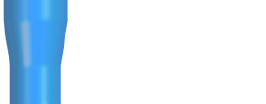
Figure 1. Two-dimensional diagram of the axial-flow pump. 1. Pipe 2. Impeller 3. Guide vane 4. Guide vane support plate. Table 1. Main geometric parameters of the model pump.